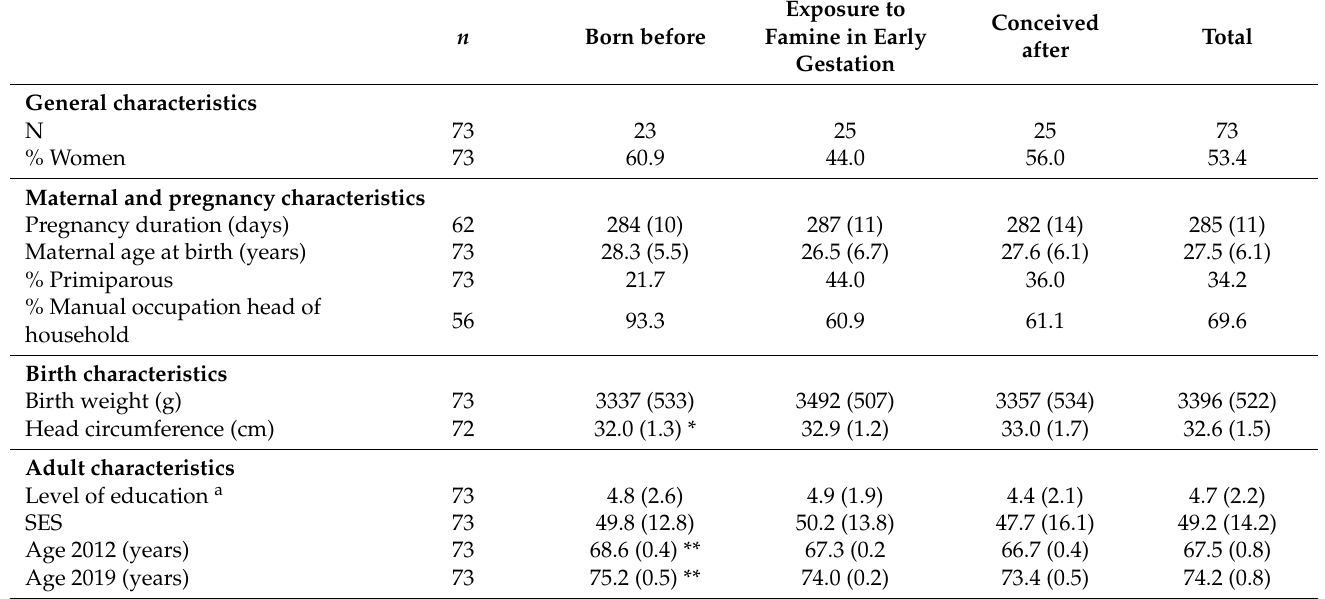
Table 1. General, maternal, pregnancy, birth and adult characteristics by timing of prenatal exposure to the Dutch famine. n Born before